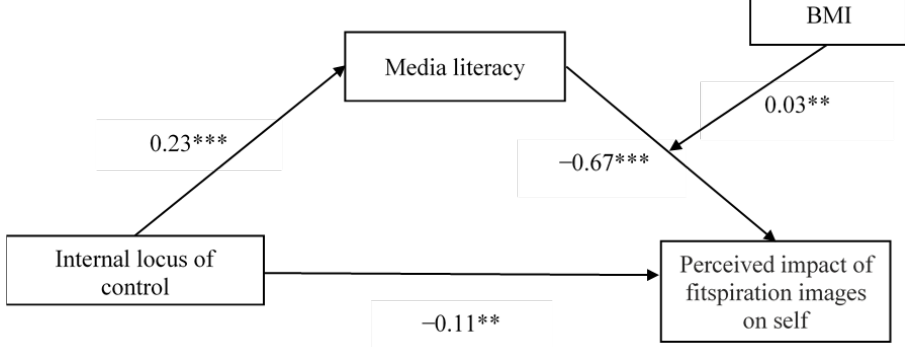
Figure 2. The moderated mediation model of media literacy and BMI while controlling for age, gender and body satisfaction. Note. BMI = Body mass index. ** p < 0.01. *** p < gender and body satisfaction. Note . BMI = Body mass index. ** p < 0.01. *** p < 0.001.